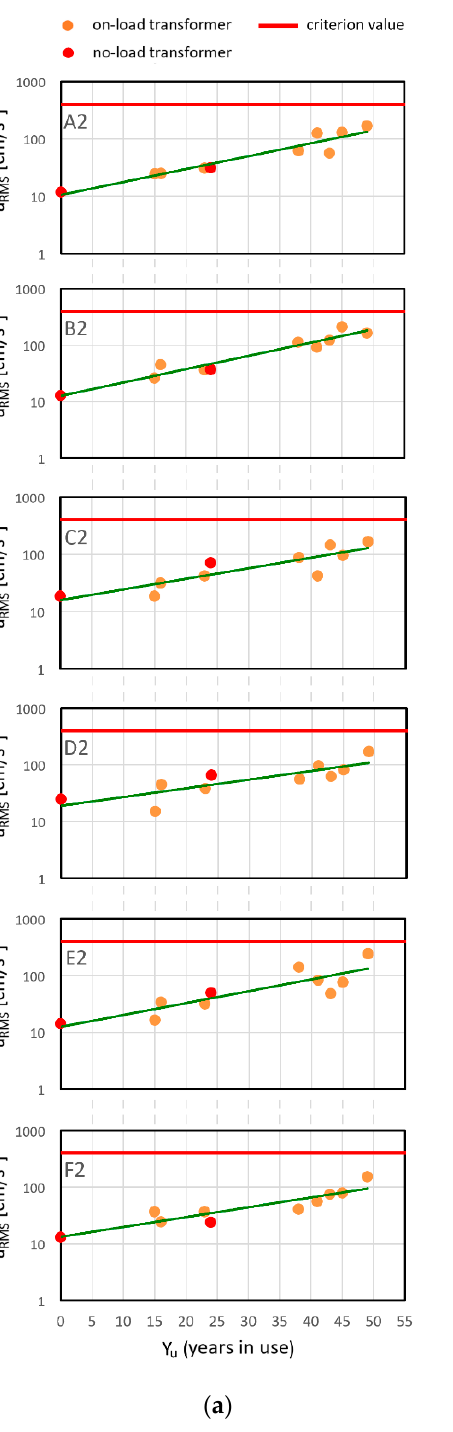
Figure 8. Root mean square values of vibration acceleration from 6 measurements points ( A2 – F2 ) depending on the age of the transformer: ( a ) for 10 transformers with the rated power of 16 MVA; ( b ) for 7 transformers with the rated power of 25 MVA.